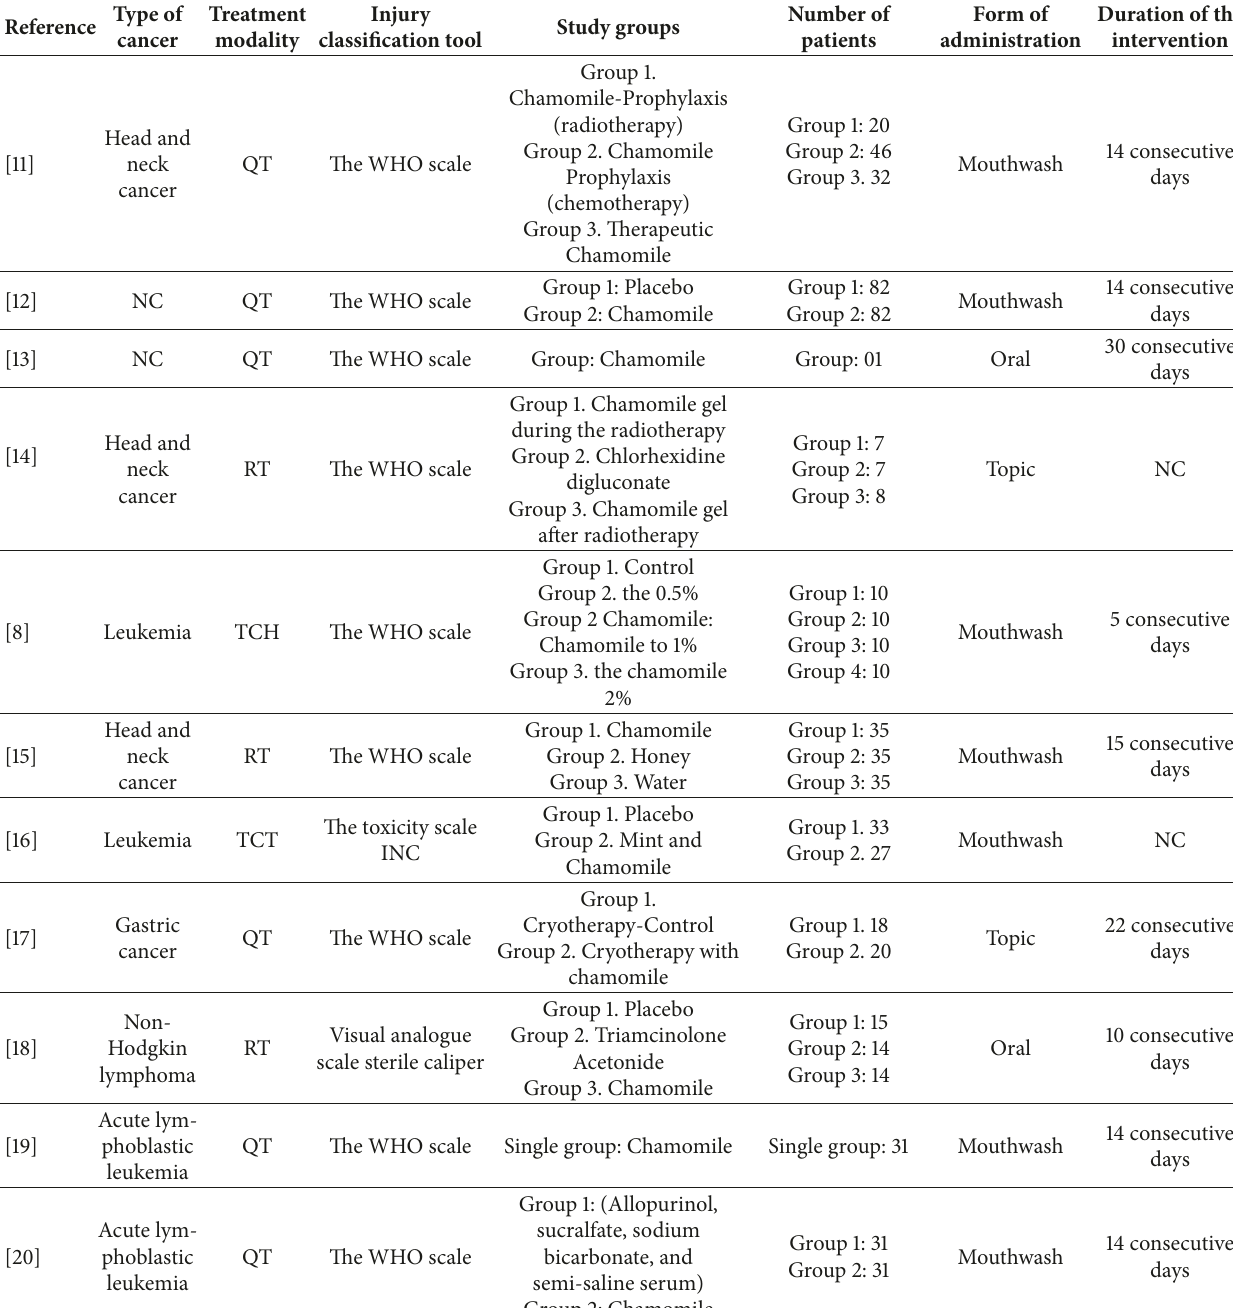
Table 2: Articles included in the review, organized in chronological order of publication: authors, year, type of cancer, treatment modality, lesion classification instrument, study groups, number of patients, form of administration, and duration of the intervention. Type of Reference